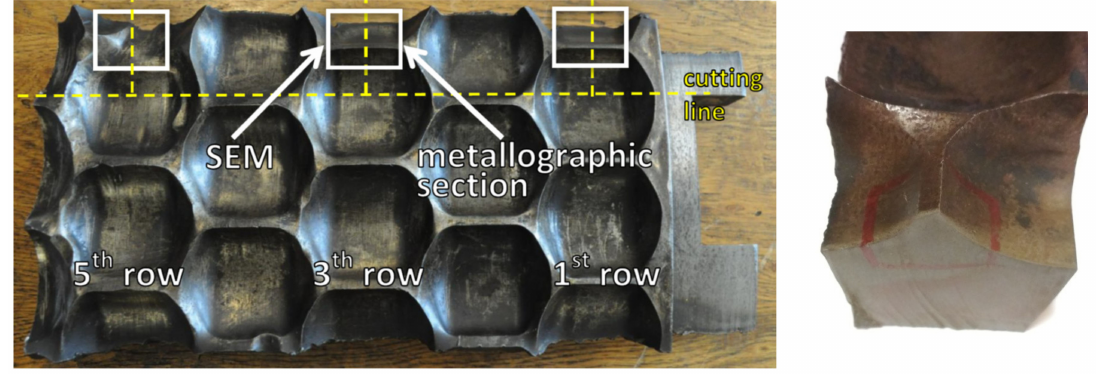
Figure 7. Place of sampling for further tests.